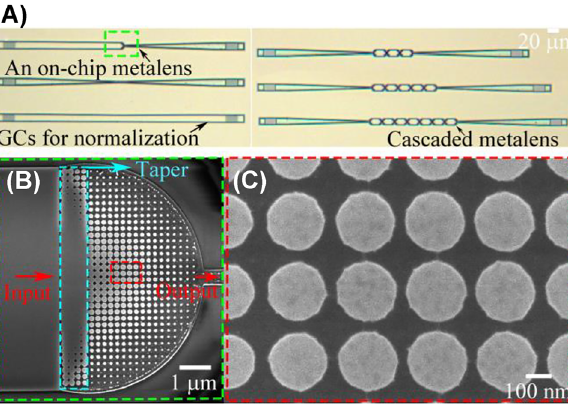
Figure 6: Photos of the fabricated on-chip GRIN metalens. (A) Optical microscope graphs of an on-chip half Maxwell’s fisheye lens, cascaded half Maxwell’s fisheye lenses, and grating couplers. (B) SEM photo of the fabricated on-chip half Maxwell’s fisheye lens. (C) Magnified SEM image of the periodic nanorod arrays. GCs, Grating couplers.